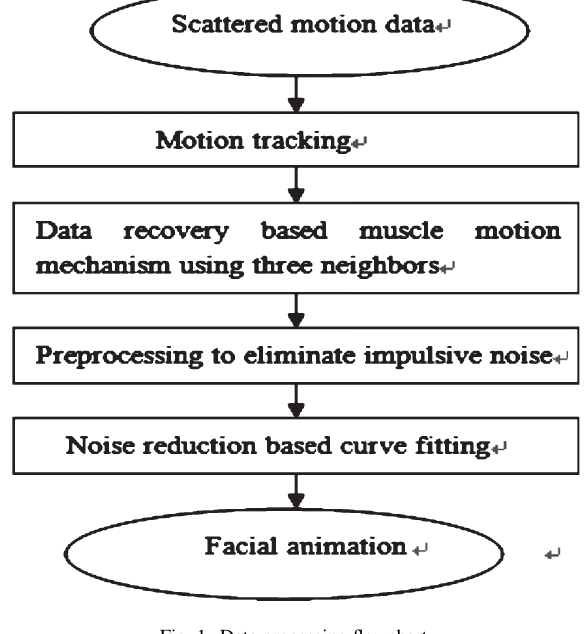
Fig. 1. Data processing